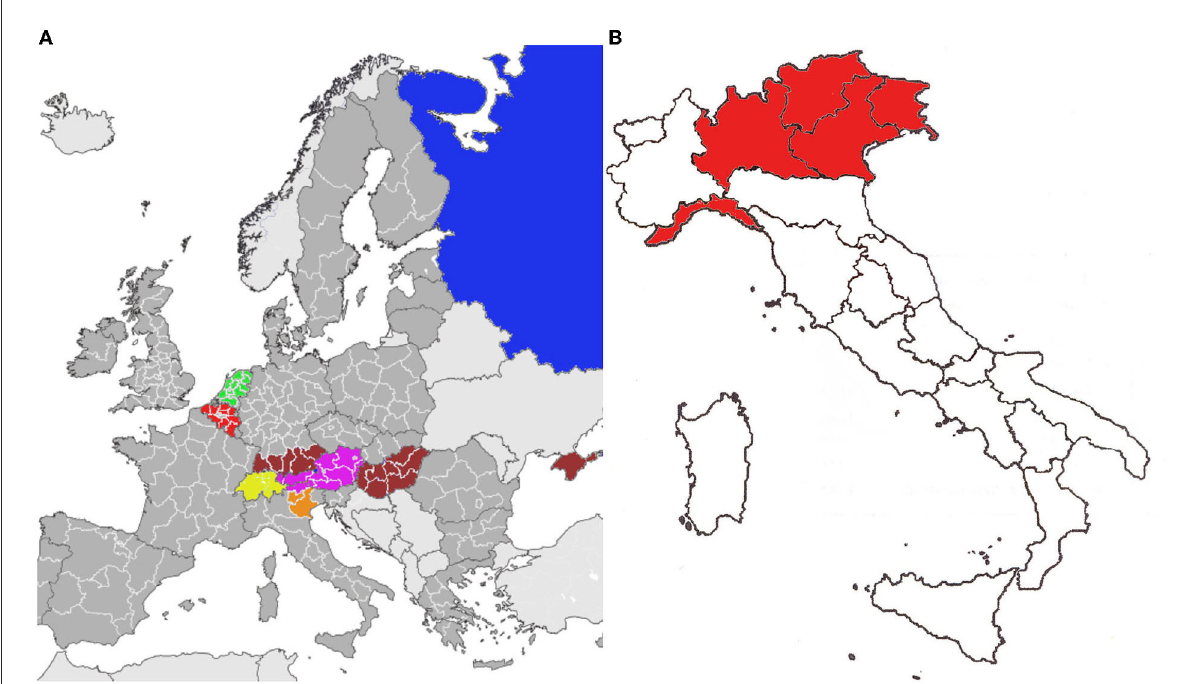
FIGURE1 Aedes koreicus evidence. (A) The first evidence in the European area (colored area represents A. koreicus first detection along with the first recording date). Red 2008: Belgium (Versteirt et al., 2012); orange 2011: Italy (Valbelluna, Province of Belluno, Veneto Region) (Capelli et al., 2011); yellow 2013: Switzerland (Suter et al., 2015); dark blue 2014: European Russia (Bezzhonova et al., 2014); brown 2016: Hungary (Kurucz et al., 2016), Germany (Southern Germany) (Werner et al., 2016), and Crimean Peninsula (Ganushkina et al., 2020); violet 2018: Austria (Fuehrer et al., 2020); and green 2021: the Netherlands (Teekema et al., 2022). (B) Northern Italy diffusion from 2011 to 2021. Red: Veneto, Trentino Alto Adige, Friuli Venezia Giulia, Lombardia, and Liguria (Montarsi et al., 2013, 2015b; Marcantonio et al., 2016; Baldacchino et al., 2017b; Gradoni et al., 2021; Negri et al.,